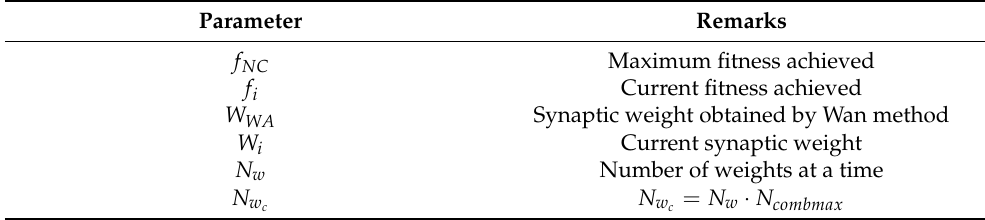
Table 2. List of parameters in the learning